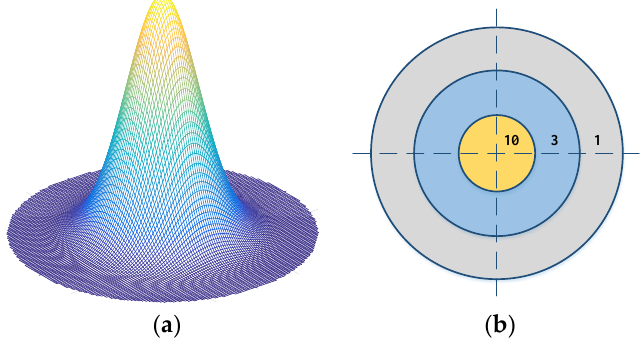
Figure 5. Illustration of the proposed similarity metric (i.e., score of nearest pixels (SNP)). ( a ) 2D Gaussian distribution model; ( b ) The scoring model for SNP